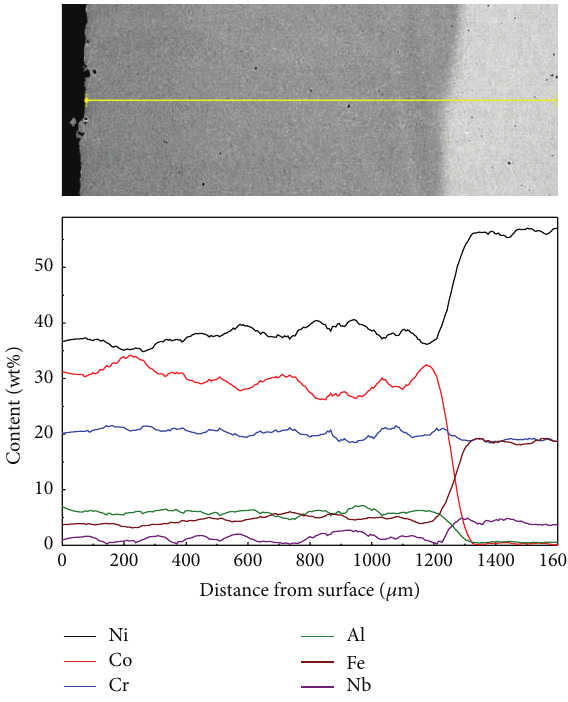
Figure 4: Transient character of the interface in EB treated CS samples measured by linear EDX method.